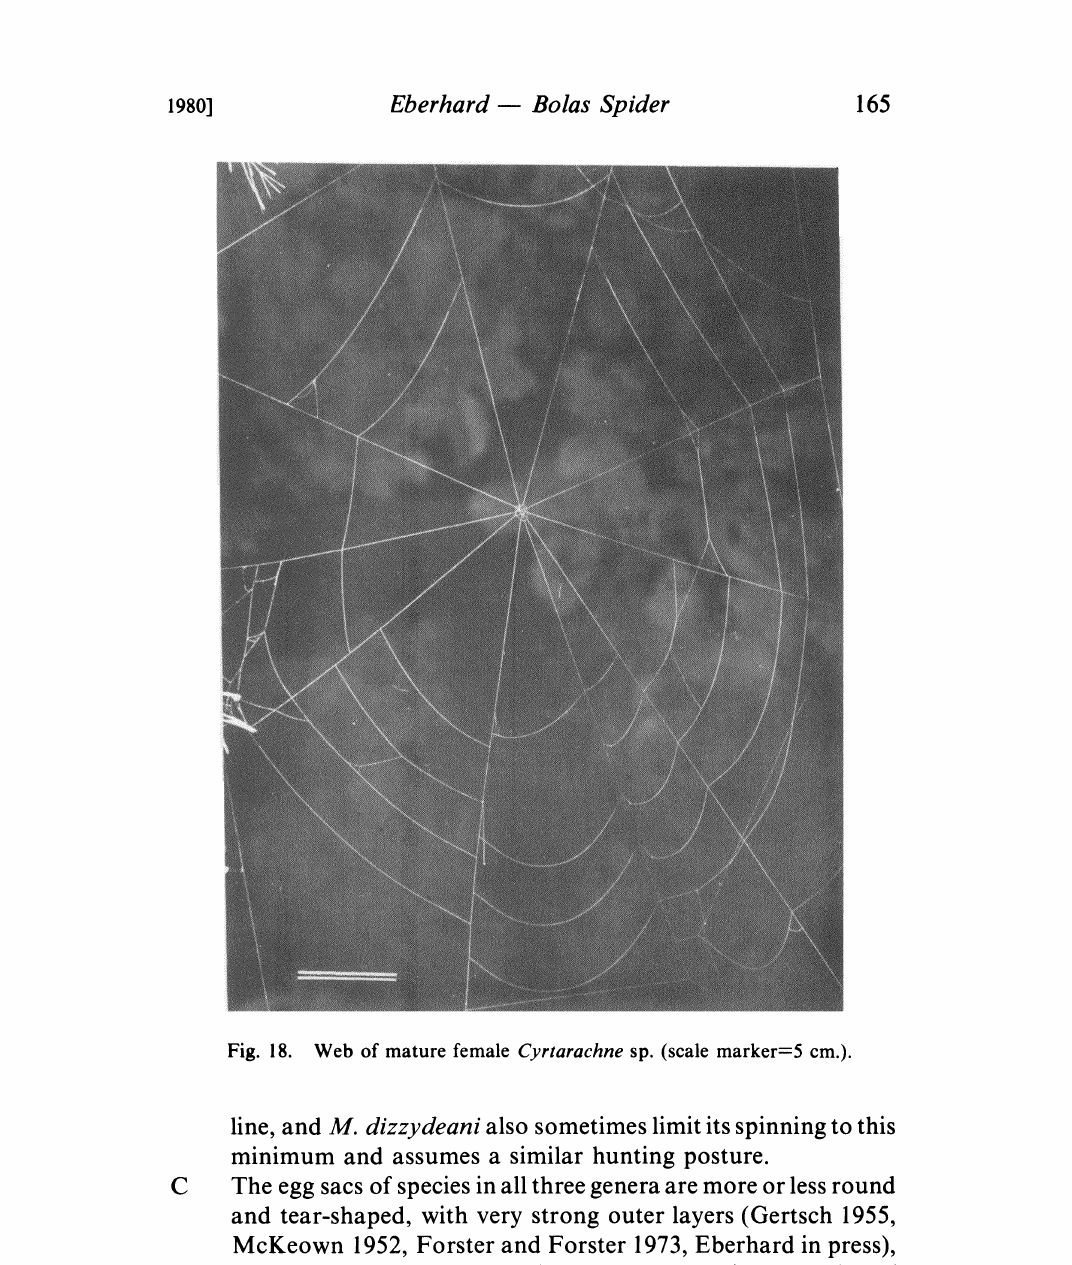
Fig. 18. Web of mature female Cyrtarachne sp. (scale marker=5 cm.).